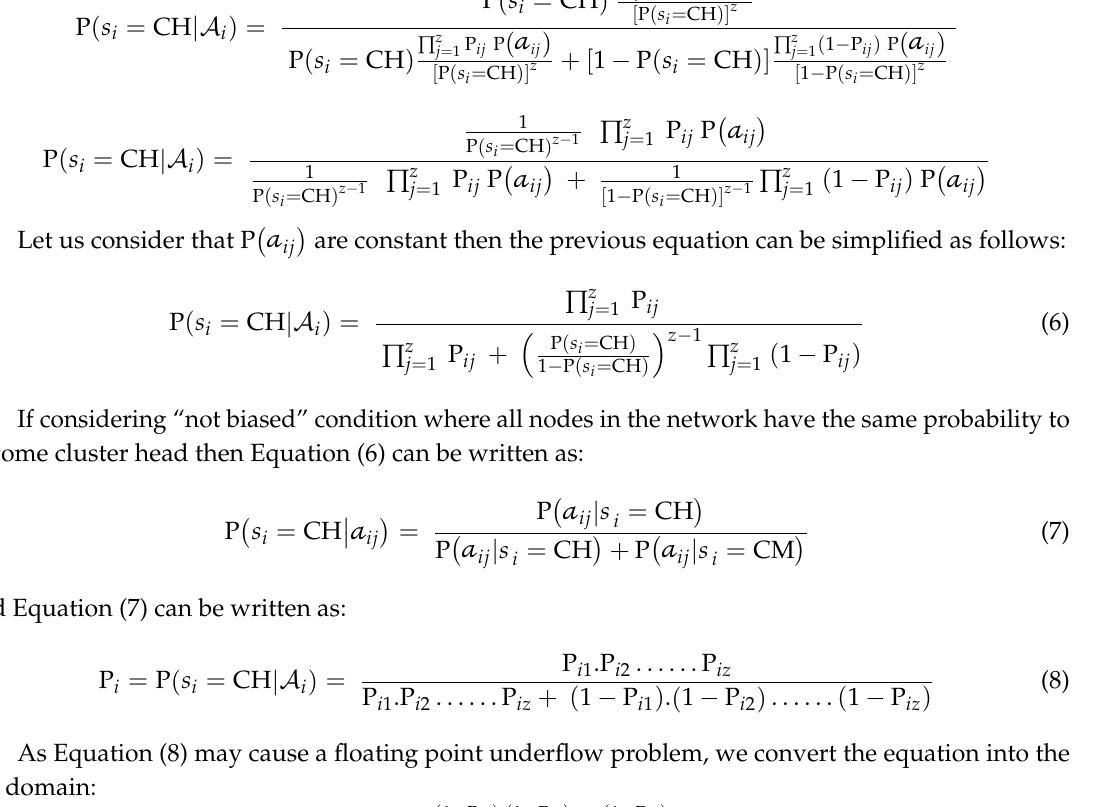
Figure 4. Dynamic clustering scheme.